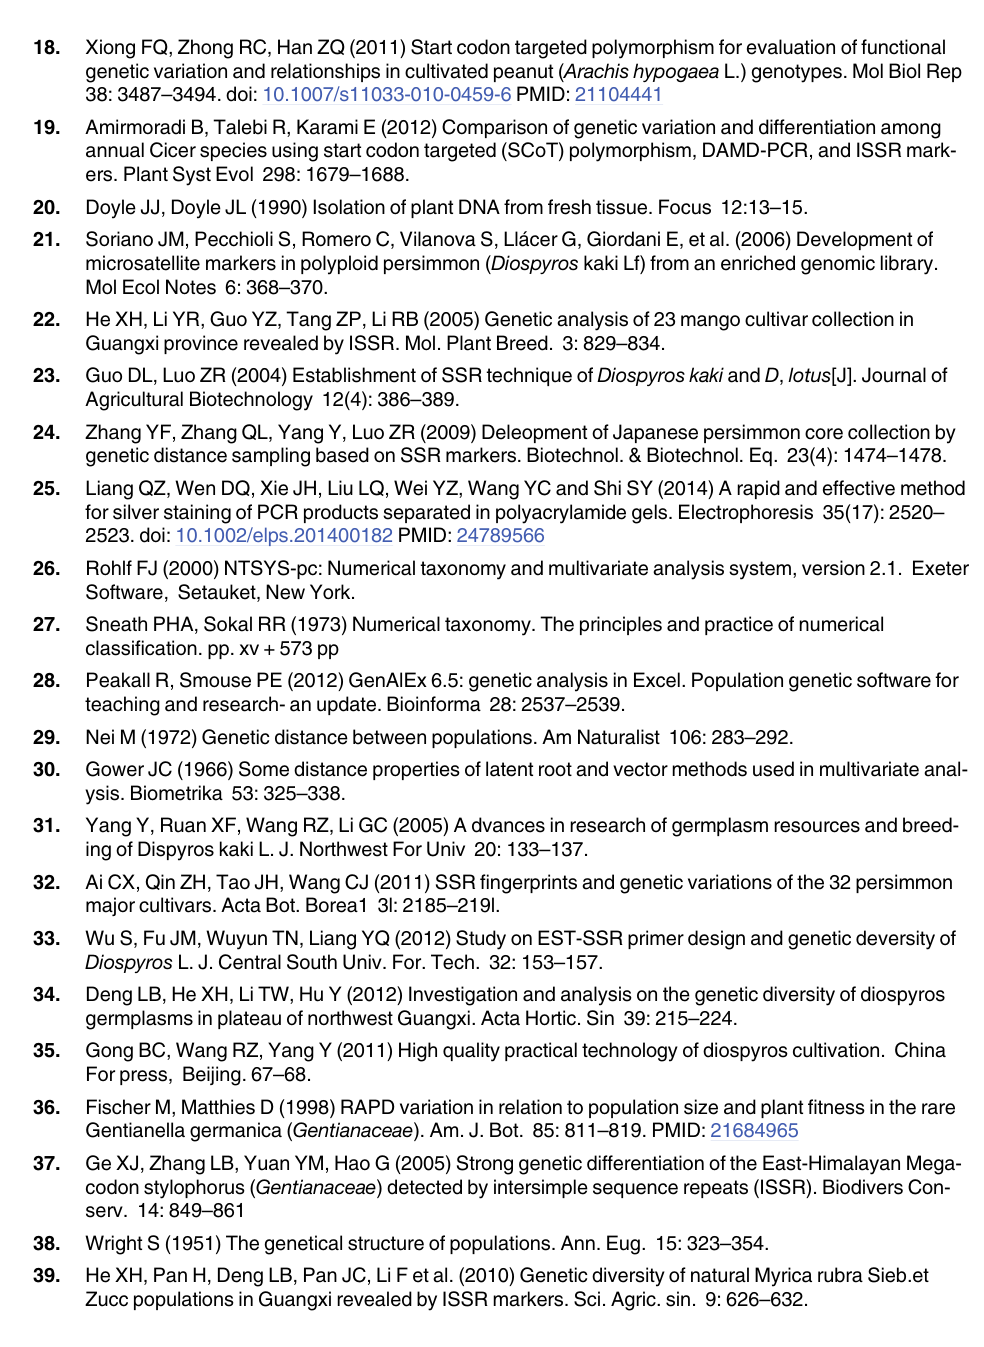
PLOS ONE | DOI:10.1371/journal.pone.0136510 August 28,